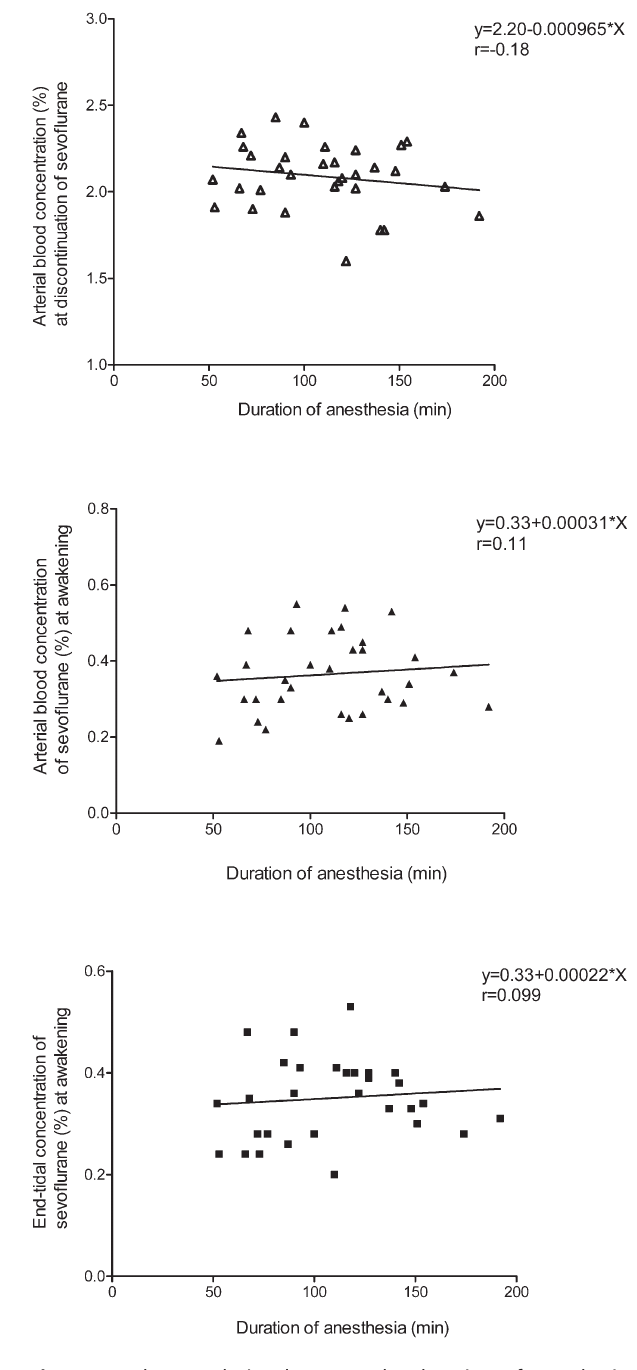
Figure 1 - The correlation between the duration of anesthesia and the arterial concentrations of sevoflurane before disconti- nuation and at awakening. The arterial concentrations just prior to discontinuing 3.5% sevoflurane (upper) and at awakening (middle), as well as the awakening end-tidal concentration (lower), were not correlated with the anesthetic duration (52- 192 minutes) ( P =0.323, 0.520 and 0.880, respectively), indicating both saturated blood contents and fast alveolar washout of